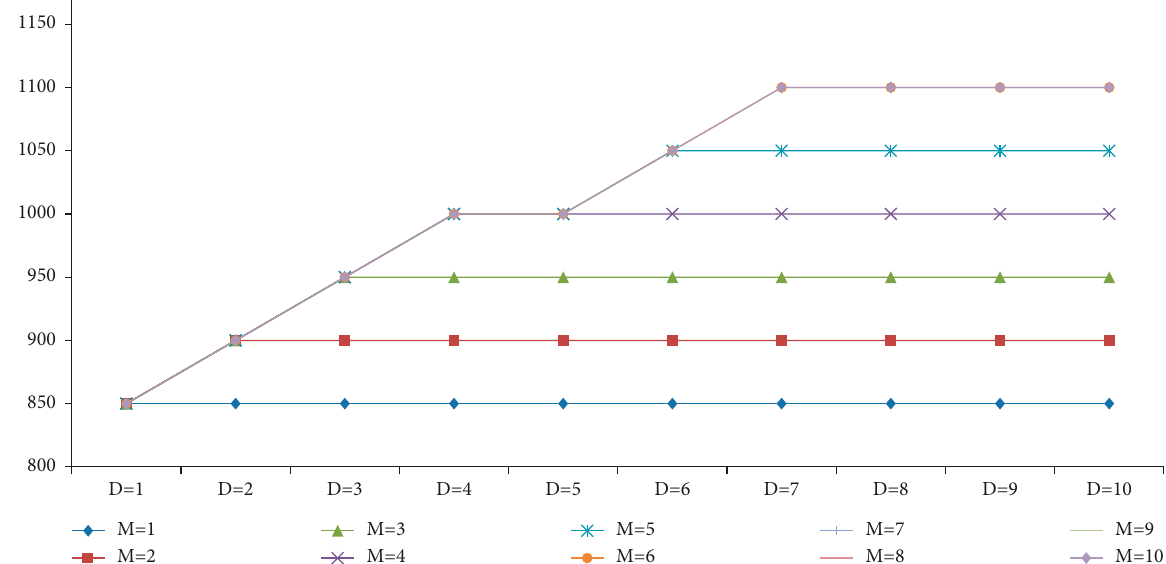
Figure 8: The number of additional passengers with different boundary